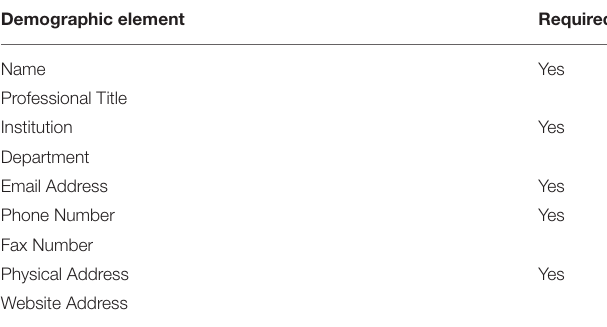
TABLE 1 | Published NCS data briefs. TABLE 2 | Registration collected demographic elements and